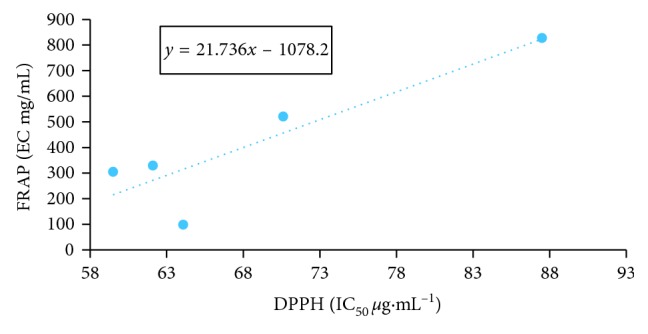
Correlation between DPPH and FRAP assays.